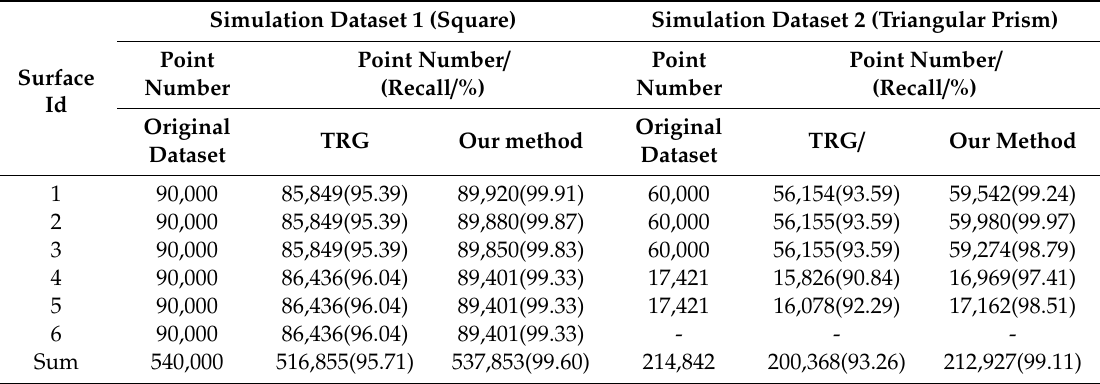
Table 3. Performance of plane segmentation for simulation